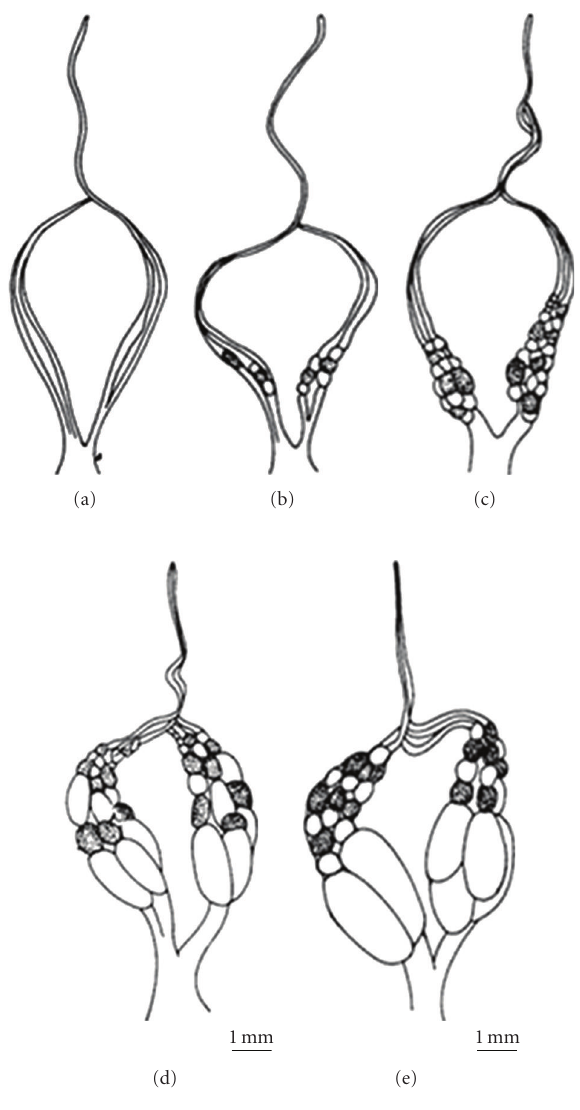
Figure 2: Grades of ovarian development found among females in colonies of Clypearia . Type (a), (b) and (c): workers; Type (d) and (e):